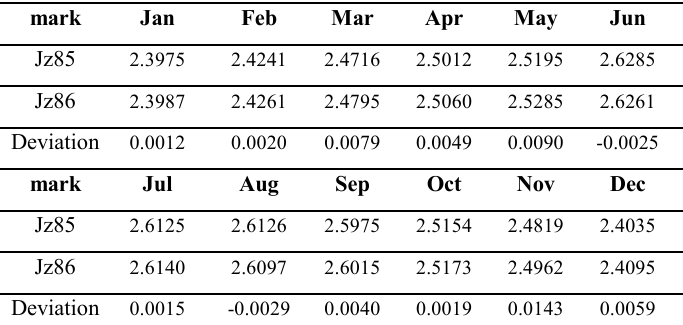
Figure 2 Deviations between ZTD estimated by GAMIT10.5